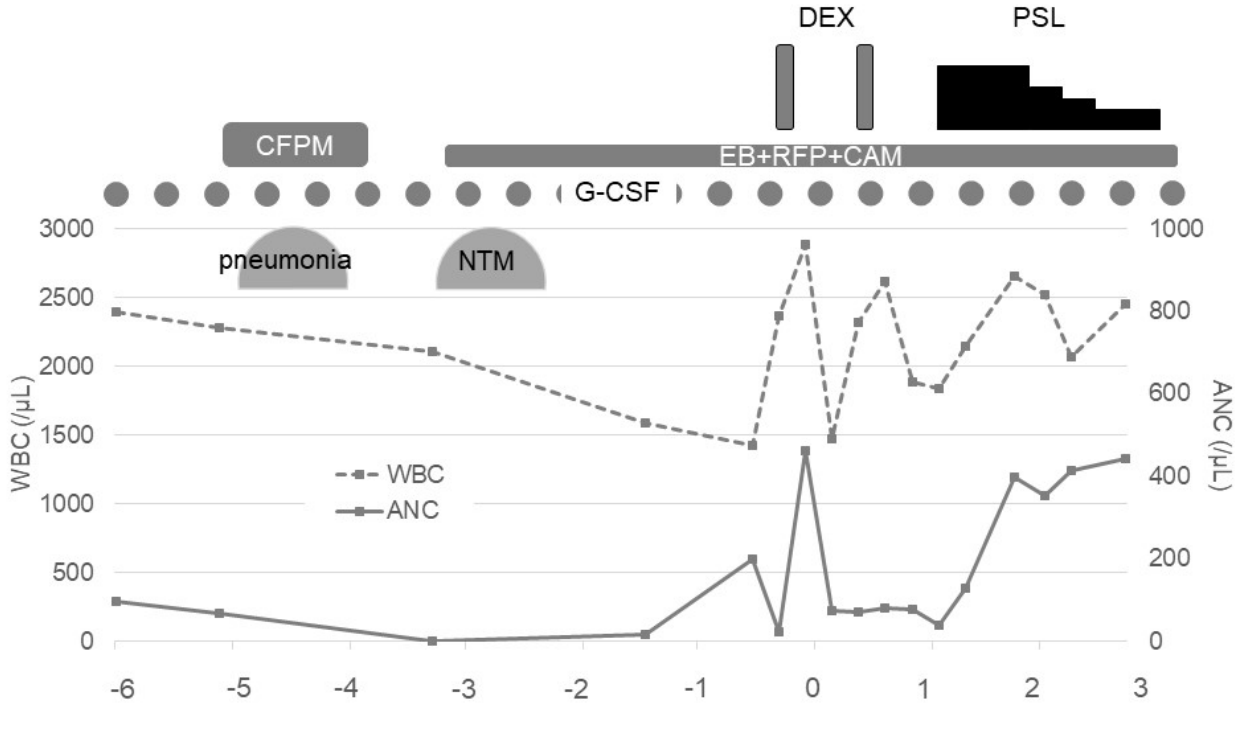
Figure 2. Clinical course before and after corticosteroid therapy. G-CSF: granulocyte colony-stimu- lating factor, CFPM: cefepime, NTM: nontuberculous mycobacteria, EB: ethambutol, RFP: rifam-